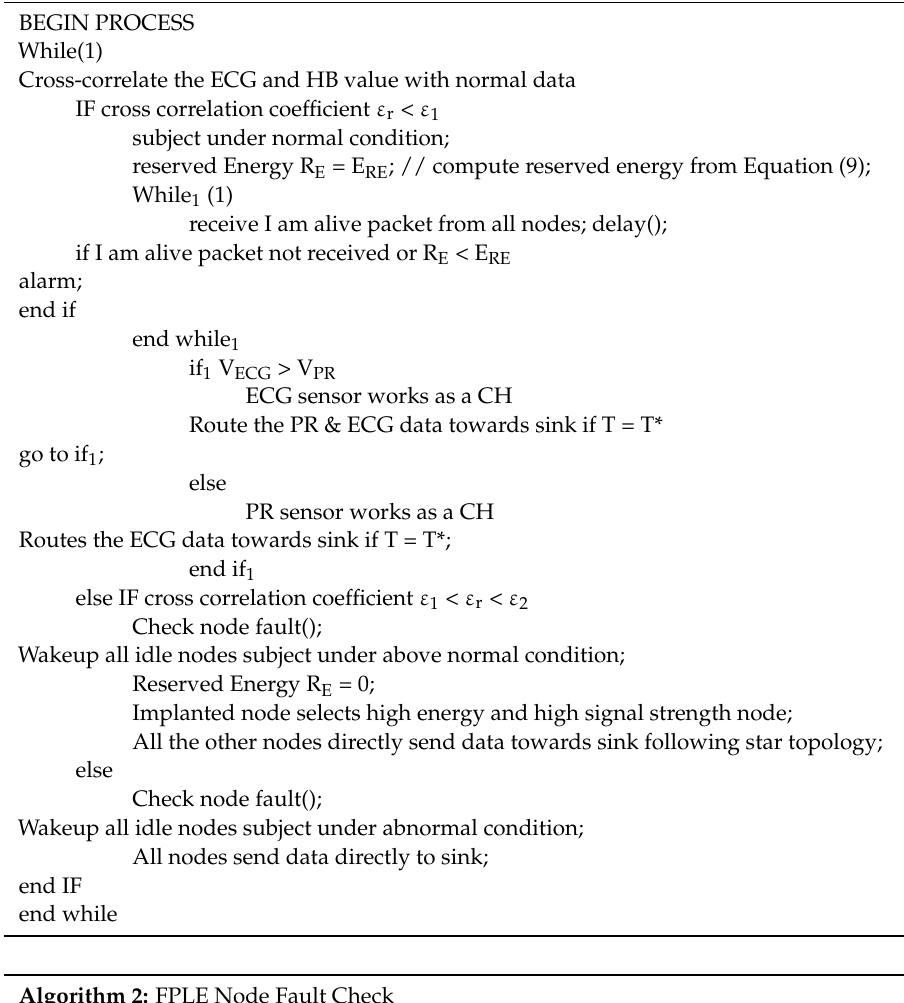
Algorithm 1: FPLE routing